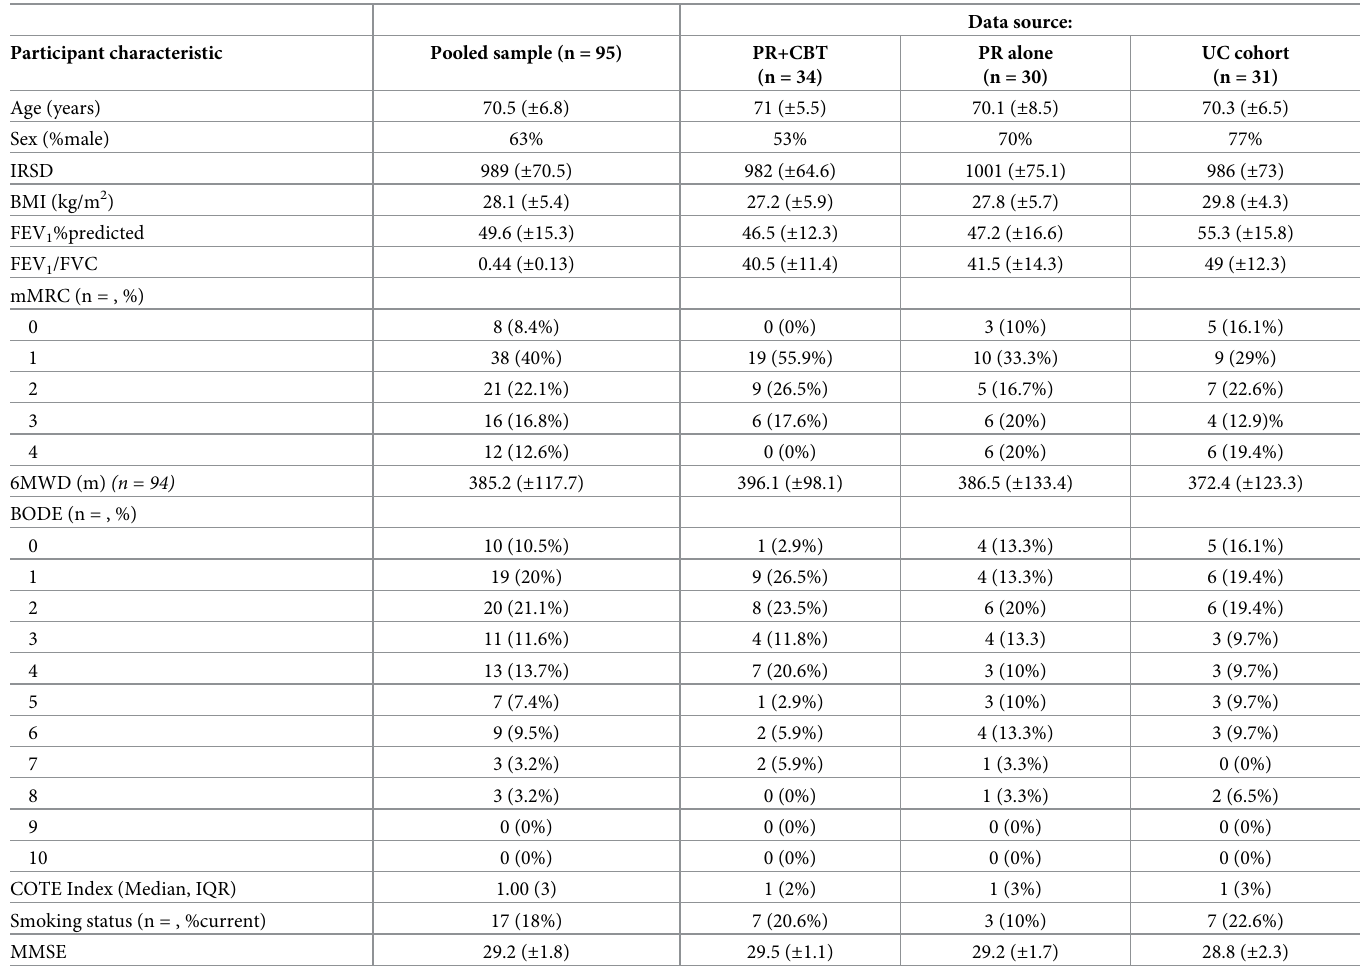
Table 2. Participant characteristics at